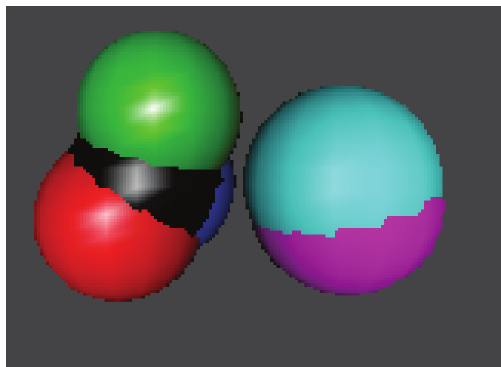
Figure 5: Results of bootstrapped PCA examining di ff erences between ethogram and visitor data. Black = ethogram data for group of otters, red = ethogram data for otter 1, green = ethogram data for otter 2, dark blue = ethogram data for otter 3, light blue = corrected visitor data, and pink = uncorrected visitor data. Cumulative proportion of variance explained by first 3 principal components =